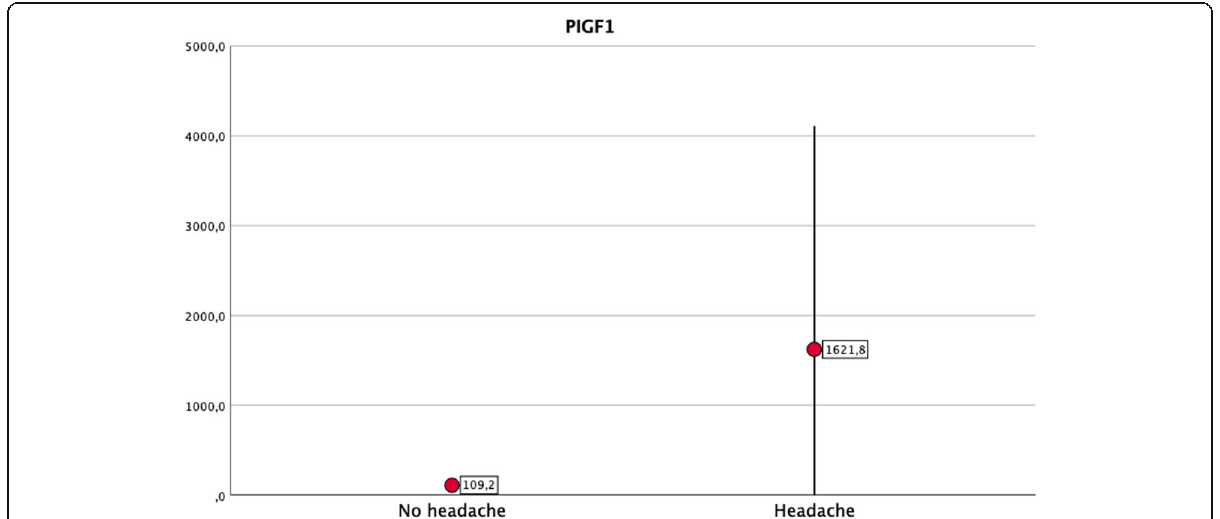
Fig. 3 Comparison of median PIGF1 levels between COVID-19 patients with and without headache by ANCOVA test, adjusting for age, sex, baseline disability and COVID-19